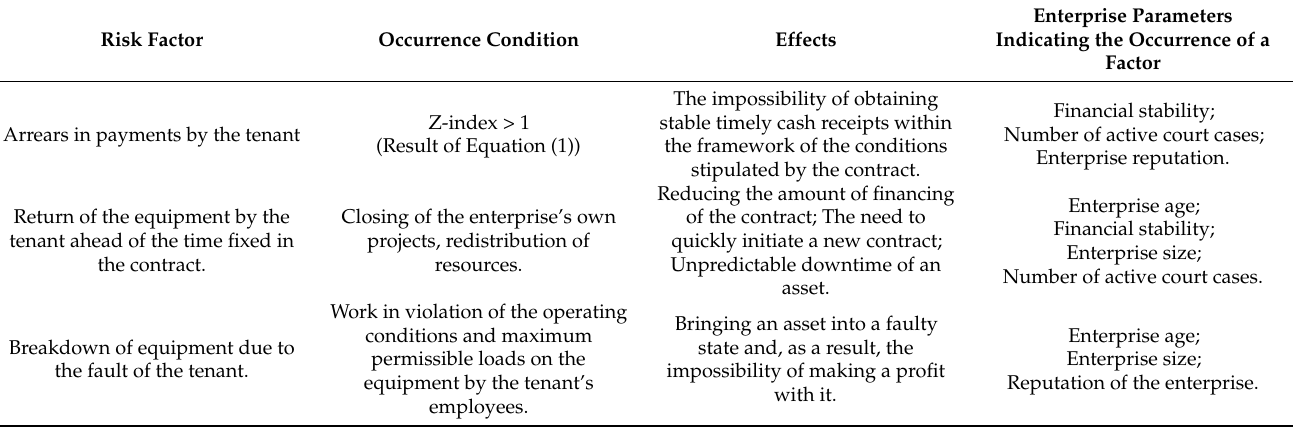
Table 3. Relationship between risk-forming factors and parameters of the tenant’s